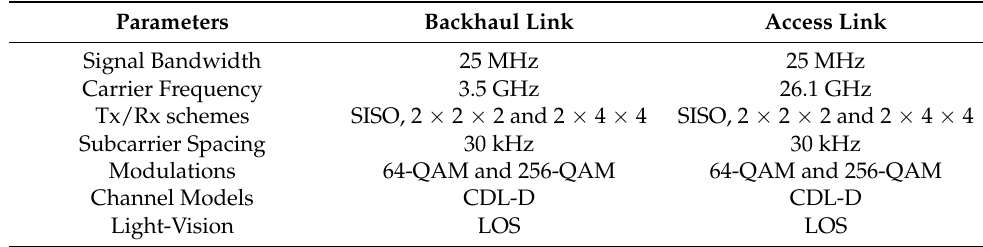
Table 3. Main parameters of